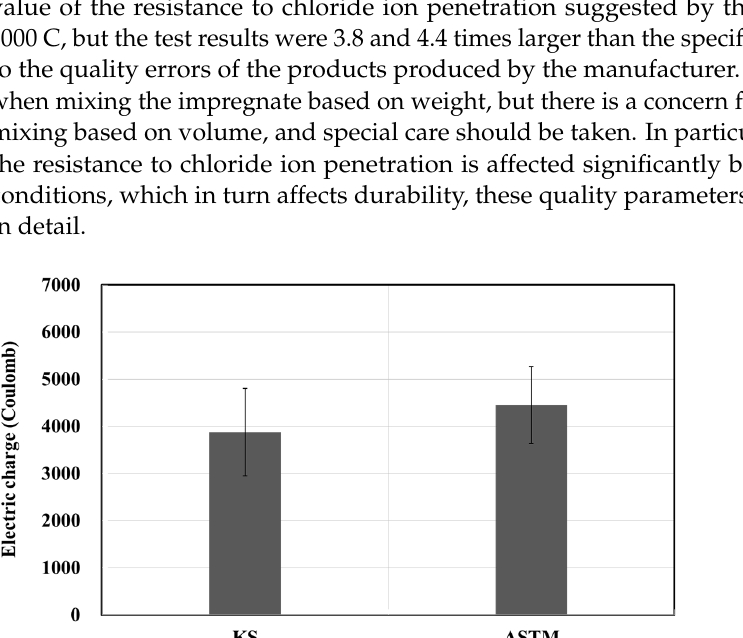
Figure 3. Chloride penetration depth test results based on the KS and ASTM standards. 3.2.3. Freezing-Thawing Test The resistance to the freeze-thaw test was performed in accordance with KS F 2456 (Standard test method for resistance of concrete to rapid freezing and thawing) and ASTM C 666 (Standard test method for resistance of concrete to rapid freezing and thawing)— test methods that freeze in air and thaw in water [19,20]. Freezing and thawing in the temperature range of − 18~4 °C for 4 h was set to occur in one cycle. The tests were con- ducted for 0, 100, 200, and 300 cycles, and the relative dynamic elastic modulus and dura- bility factor of the concrete were measured by resonance vibration. Equation (1) is the expression for the relative dynamic elastic modulus and Equation (2) is the expression for the durability factor,